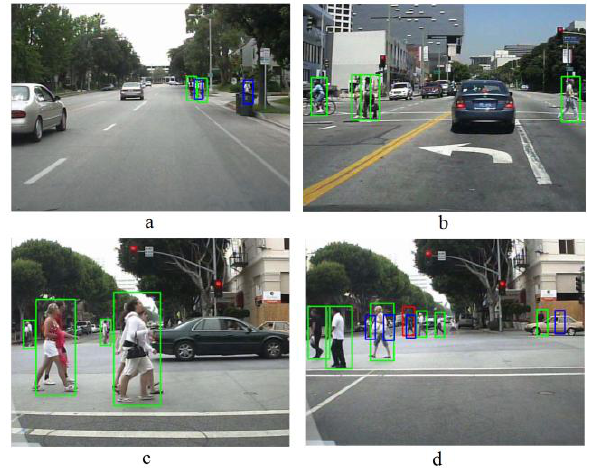
Figure 3. The obtained detection results using Caltech Pedestrian Detection dataset: a far distance, b middle distance, c close distance, d middle and far